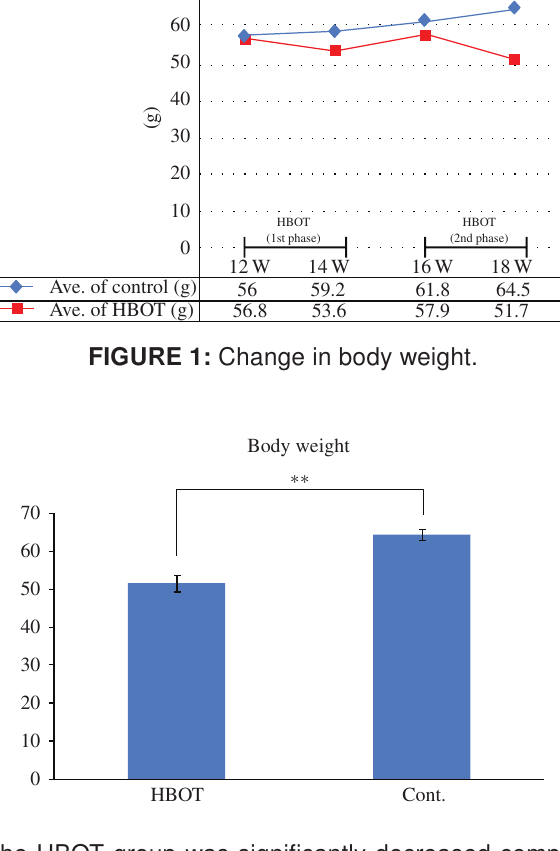
FIGURE 2: The weight of the HBOT group was significantly decreased compared with that in the control group (Student’s t -test, ∗∗ P < 0 . 01